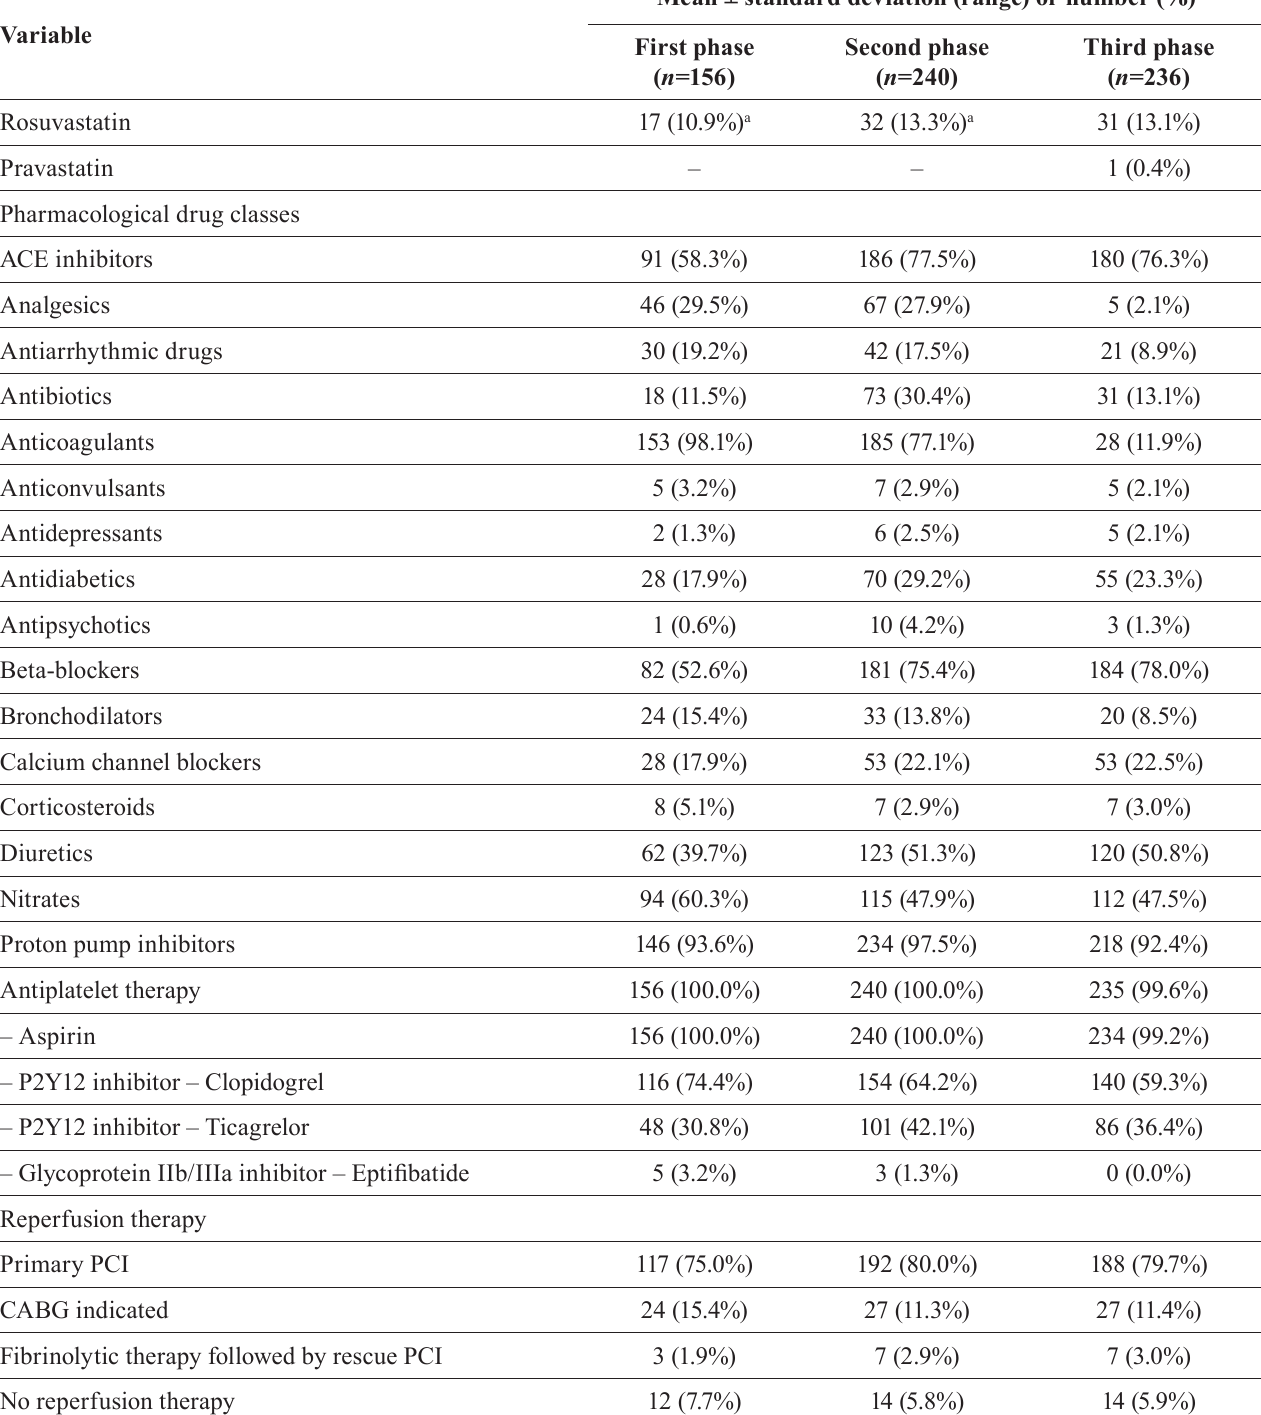
Mean ± standard deviation (range) or number